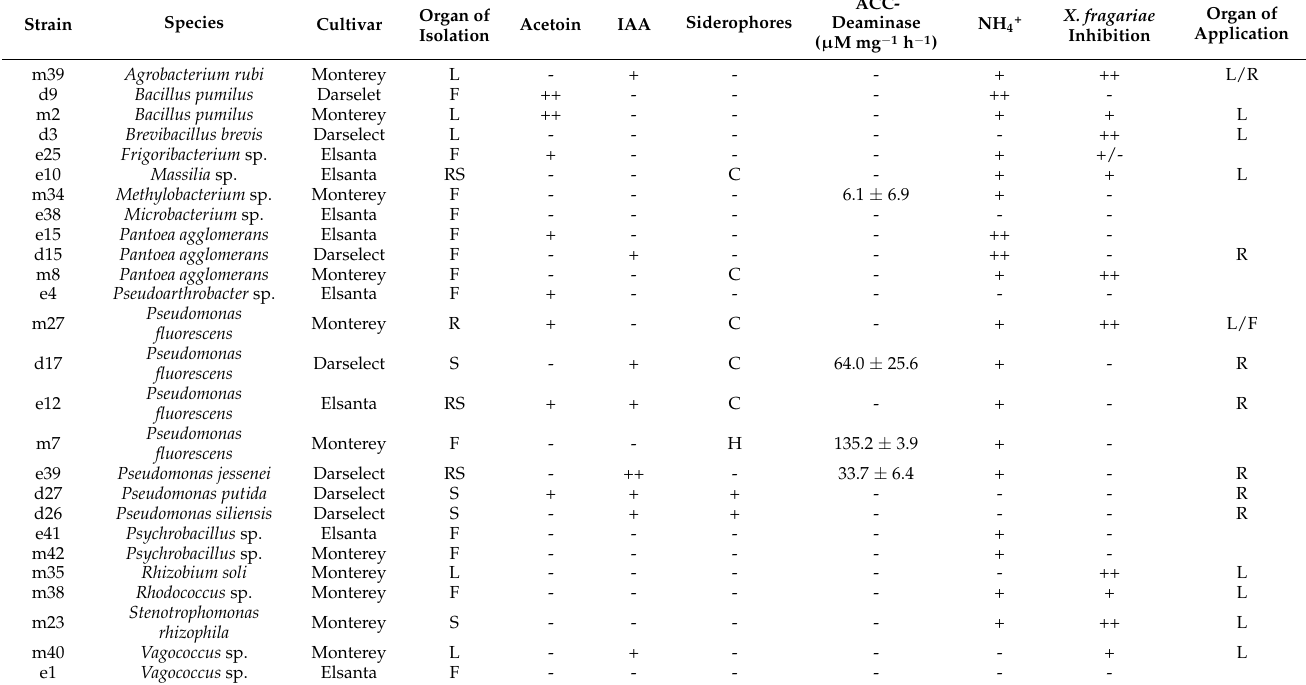
Table 1. List and in vitro functional characterization of bacterial strains selected for root and leaf in- oculation. Qualitative assessment: +, detectable activity; ++, high activity; -, no activity. Siderophores type: C, carboxylate; H, Hydroxamate type. Organs of isolation and application: F, fruit; L, leaf; R, root; RS, rhizosphere; S,